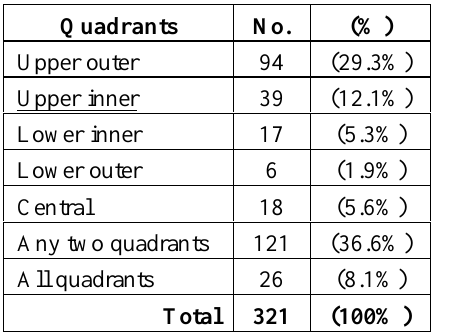
Table III. Locations of breast cancer cases in different